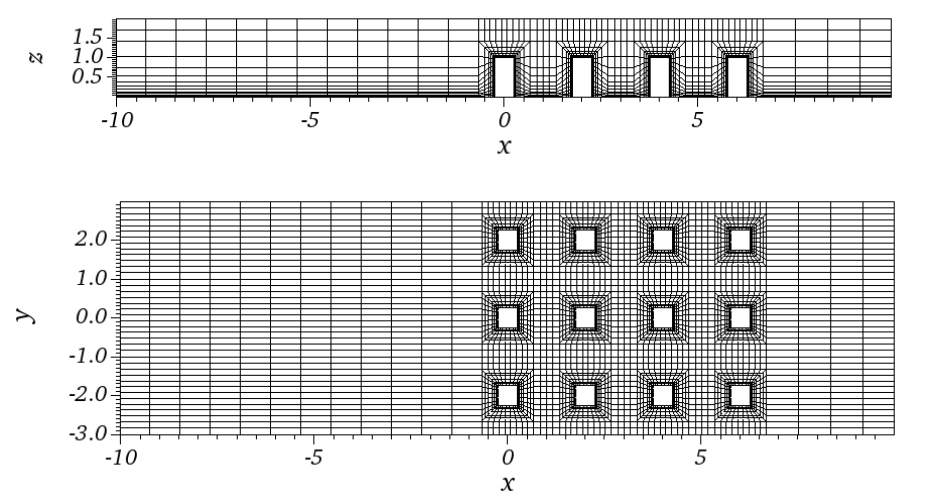
Figure 2. Slices of the spectral-element mesh: ( top ) slice at z = 0 and ( bottom ) slice at y = 0.1 (where the lengths are scaled with the building height). Note that the GLL points within elements are not